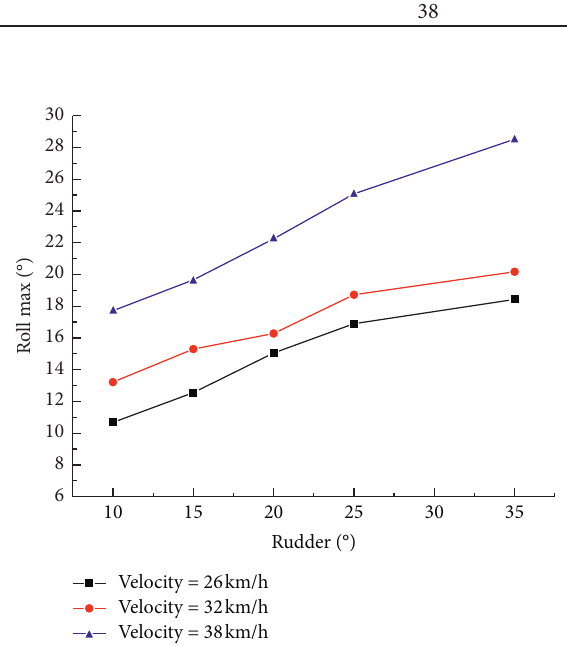
Figure 15: Maximum roll angle at 400m with respect to the rudder angle.